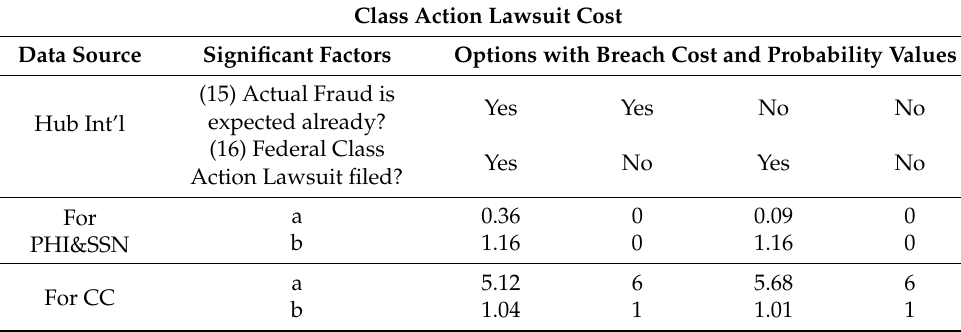
Table 8. The parameters a and b for the factors associated with class-action lawsuit